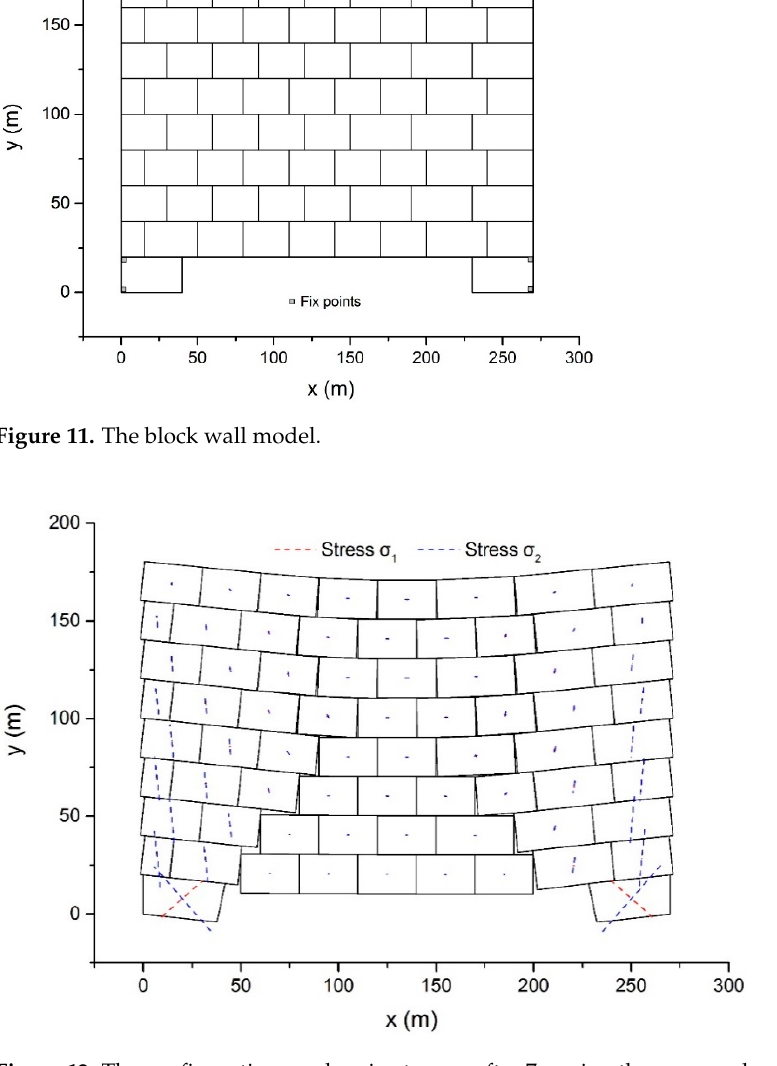
Figure 13. The configurations and main stress vectors after 7 s by DDA with the post-adjustment strategy.